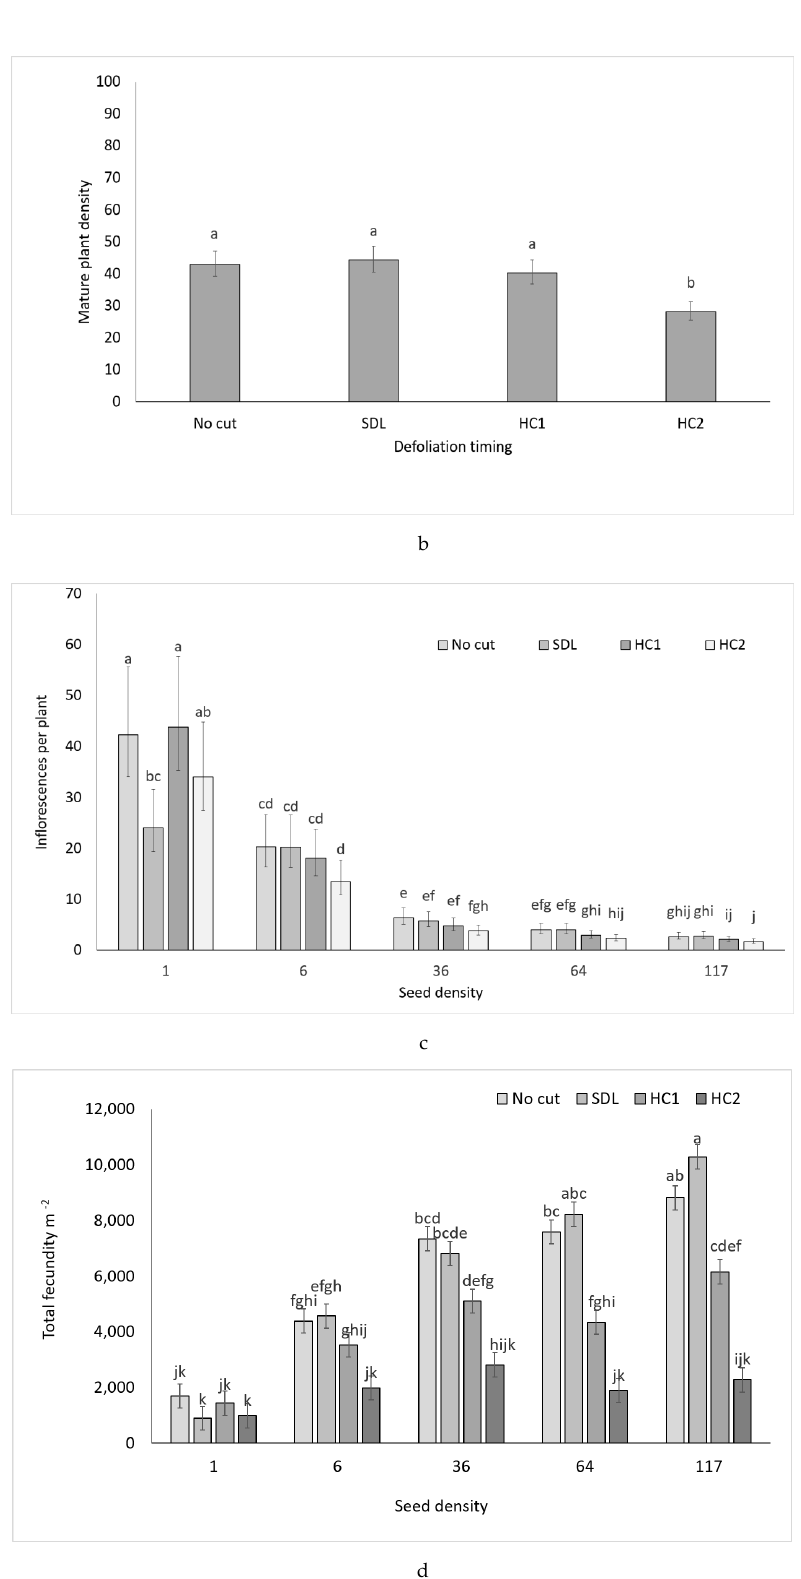
Figure 6. ( a ) Mean number of barley grass plants surviving to flowering when sown at five population densities in the greenhouse. ( b ) Mean number of mature barley grass plants in response to defoliation timing and frequency. ( c ) Mean number of barley grass inflorescences per plant. ( d ) Mean total fecundity, as a result of the interaction between density and defoliation timing, all conducted under greenhouse conditions in Wagga Wagga, NSW. Model estimated means and 95% confidence intervals shown in all figures. Bars with the same letter are not significantly different according to Tukey’s honestly significant difference (HSD) test at α = 0.05. No cut = no defoliation, SDL = defoliation at seedling stage, HC1 = defoliation at inflorescence emergence, HC2 = defoliation of regrowth at inflorescence emergence.